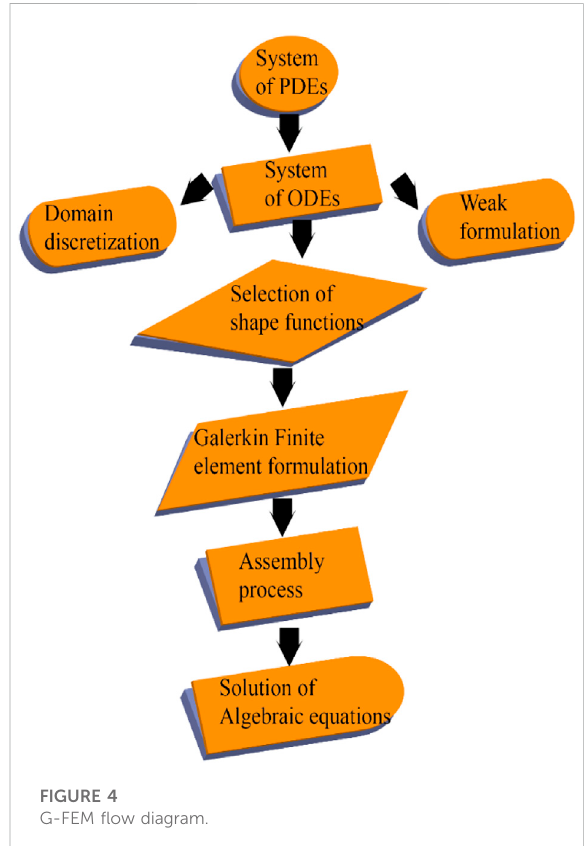
FIGURE 4 G-FEM fl ow diagram.